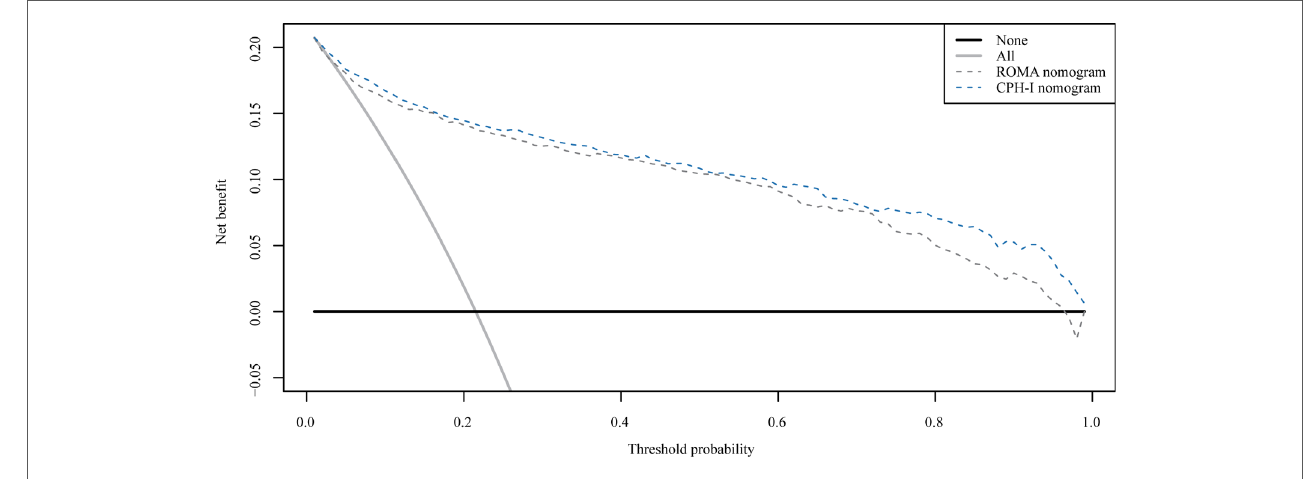
FIGURE 5 Decision curve analysis (DCA) curve for nomograms with ROMA or